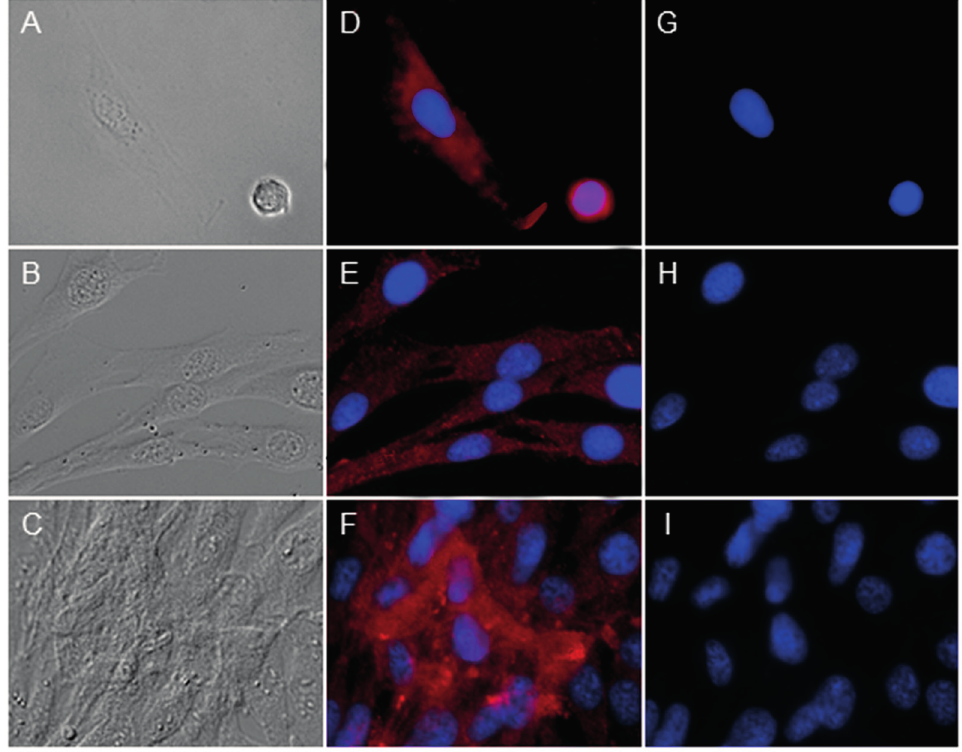
Figure 4. Investigation of peripherin 2 (red) and rhodopsin (green) expression on cultivated healthy RPE cells at different confluency states. Differential interference contrast image of healthy equine RPE cells at different confluency states; from single cells ( A ) to 40% confluent cells ( B ) up to 90%–100% confluent cells ( C ); ( D – F ) Peripherin 2 (red) was expressed over whole RPE cells with an even intensity (cell nuclei = blue); ( G – I ) No rhodopsin (green) expression was found in primary healthy equine RPE cells (cell nuclei =